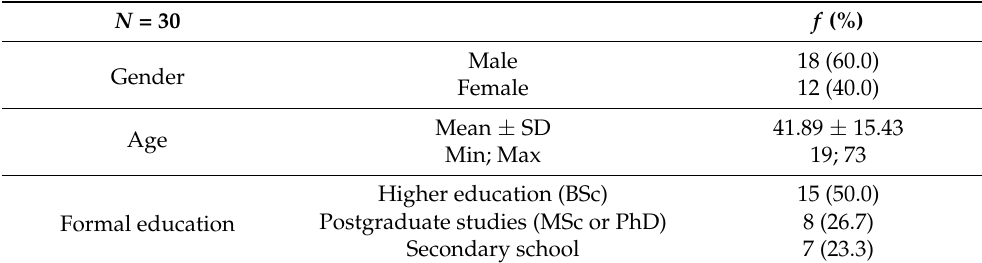
Table 4. Socio-demographic characterization of the focus groups and individual interviews